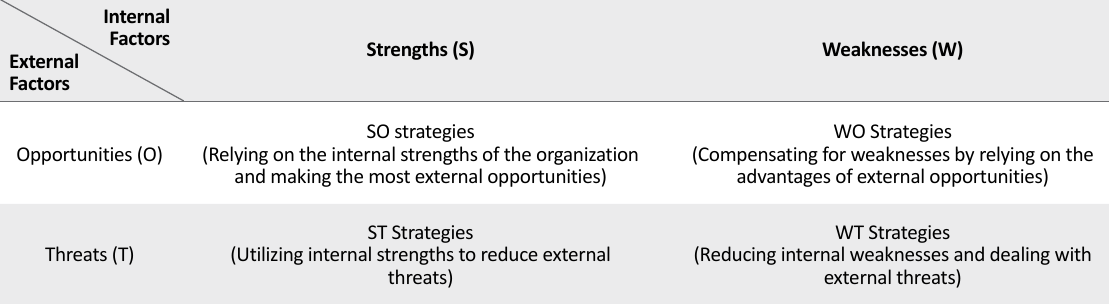
Table 1. SWOT matrix used for determination of strategies as well as executive priorities of municipal waste